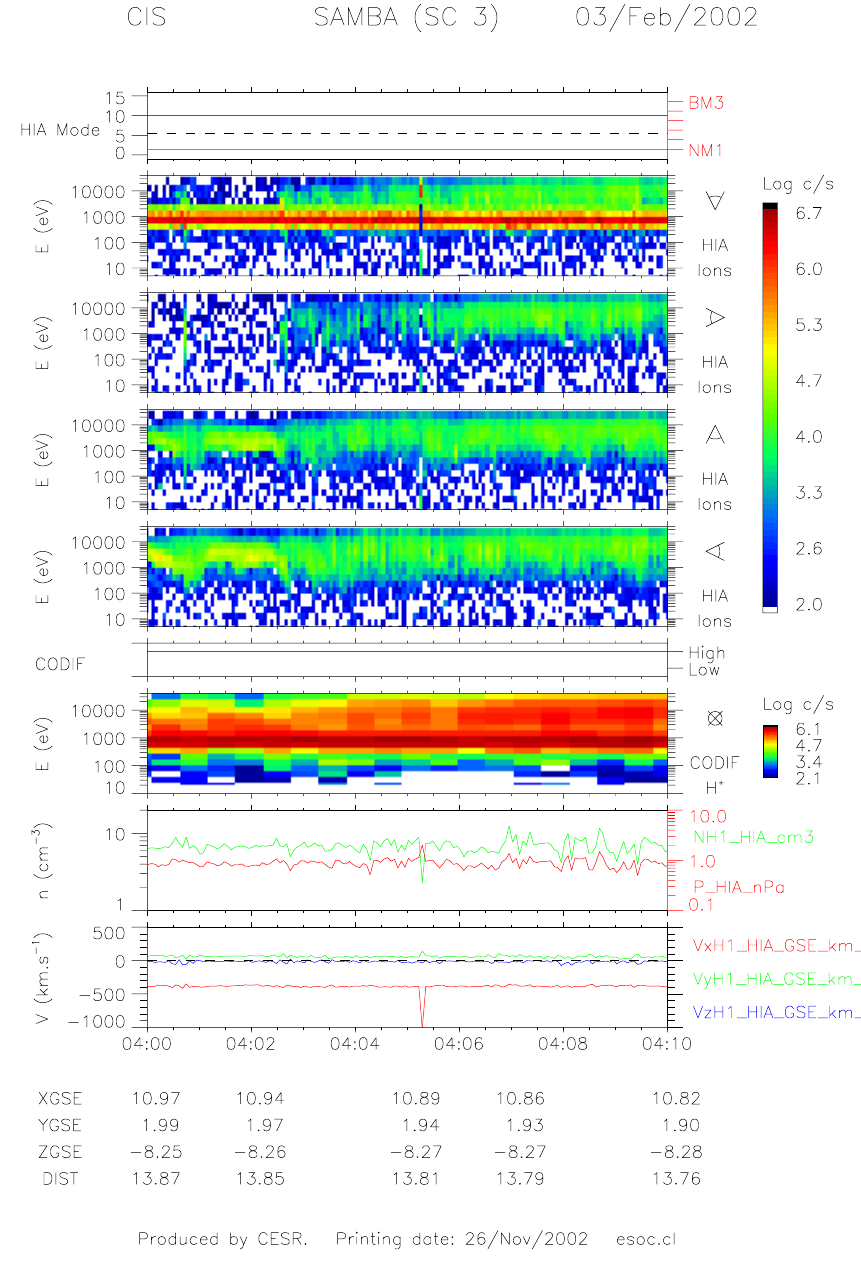
Fig. 5. Energy spectrogram from CIS s/c 3, 04:00 UT–04:10 UT, day 34, 2002. Panels 2, 3, 4 and 5 show the fluxes for all ion species in the sunward, duskward, earthward and dawnward look directions. The waves were observed after 04:02:30 UT, and are associated with a diffuse energetic ion